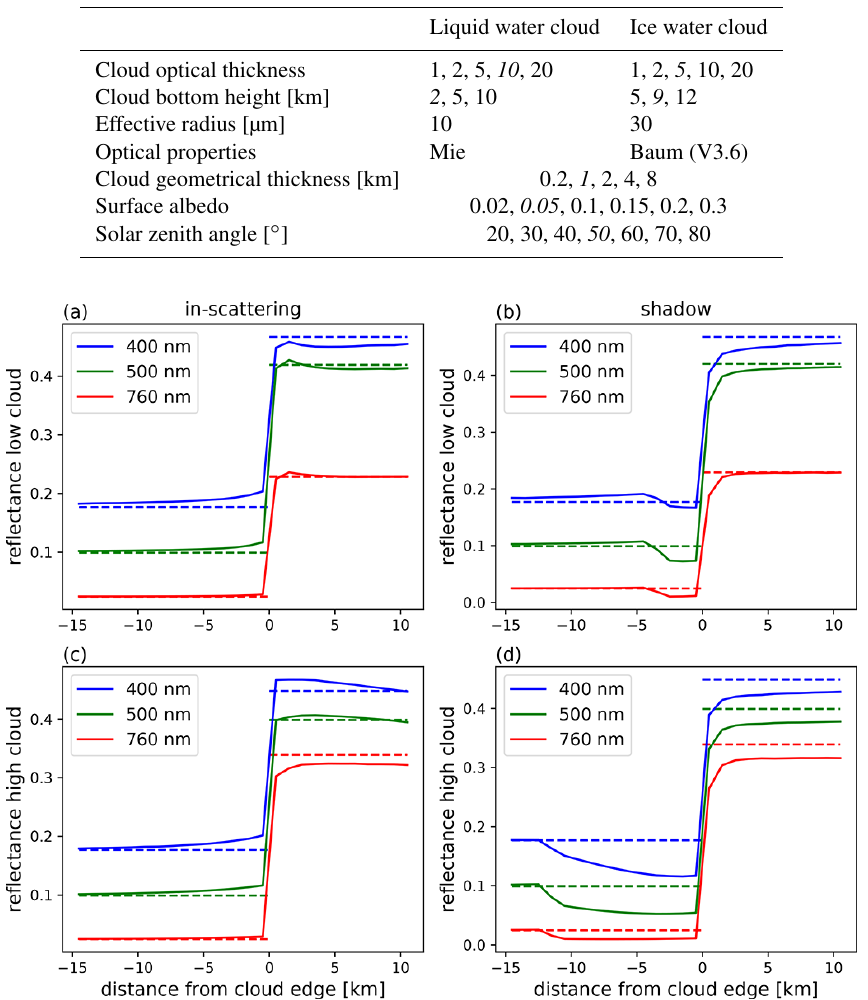
Figure 3. Reflectance as a function of distance from the cloud edge for the base case for selected wavelengths included in dataset: (a) in- scattering for liquid water cloud at low altitude, (b) shadowing for liquid water cloud at low altitude, (c) in-scattering for liquid water cloud at high altitude and (d) shadowing for liquid water cloud at high altitude. Solid lines correspond to 3D and dashed lines to 1D